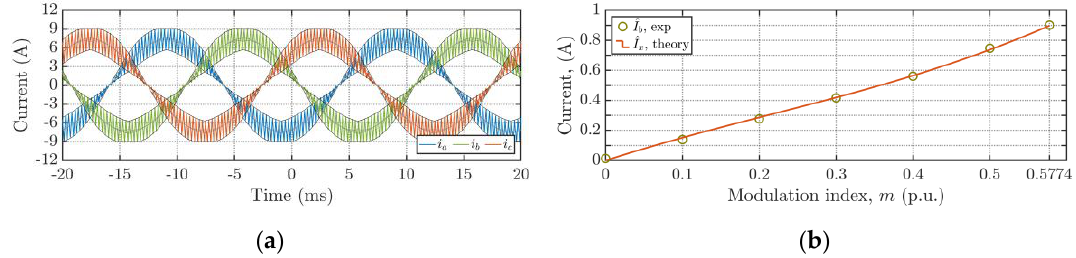
Figure 34. ( a ) Phase currents with primary (black) and secondary (gray) envelopes in case of CPWM ( m = 1/√3); ( b ) Phase current ripple rms in case of CPWM.